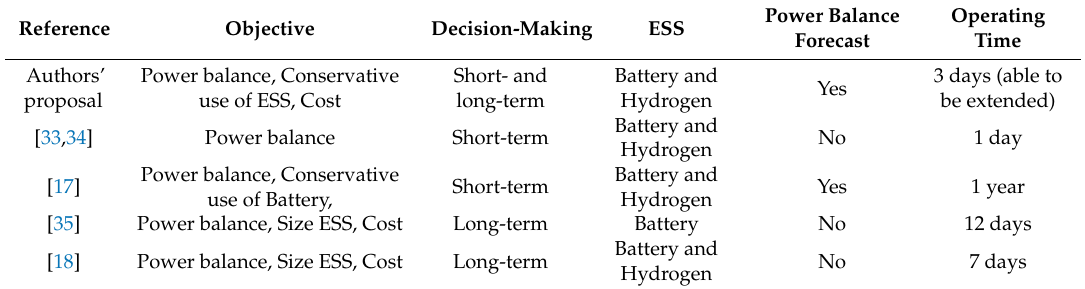
Table 1. Comparison of the findings of the proposed paper with previous scientific works.